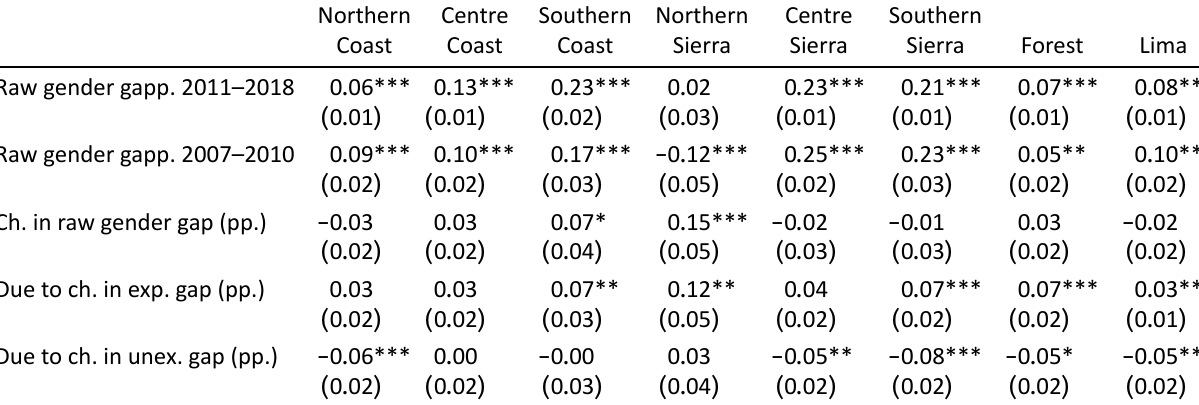
Table 6. Intertemporal wage gap decomposition, by macro‐regions.